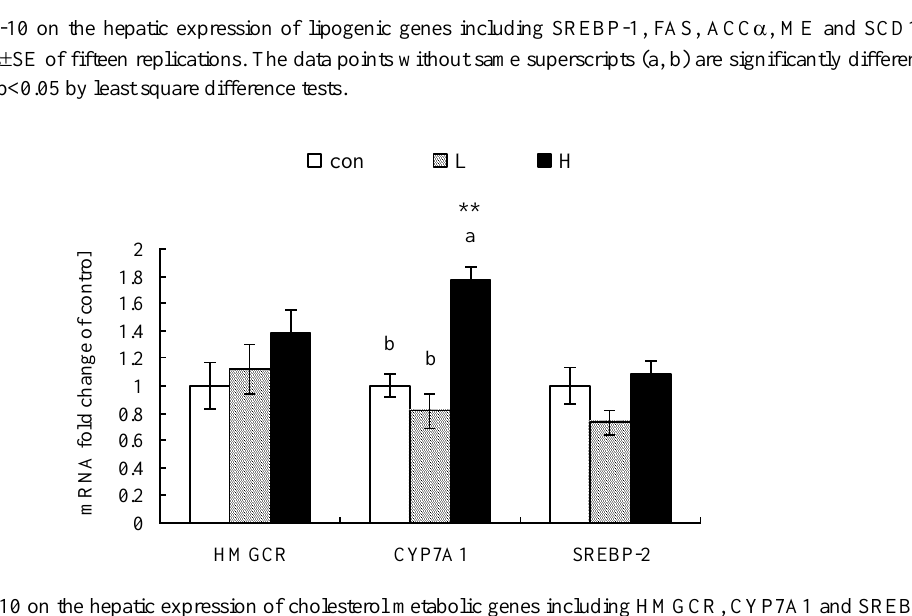
Figure 2. Effects of Kp-10 on the hepatic expression of cholesterol metabolic genes including HMGCR, CYP7A1 and SREBP-2 mRNA in quails. Values are means  SE of fifteen replications. The data points without same superscripts (a, b) are significantly different (one- way ANOVA) at the level of p<0.05 by least square difference